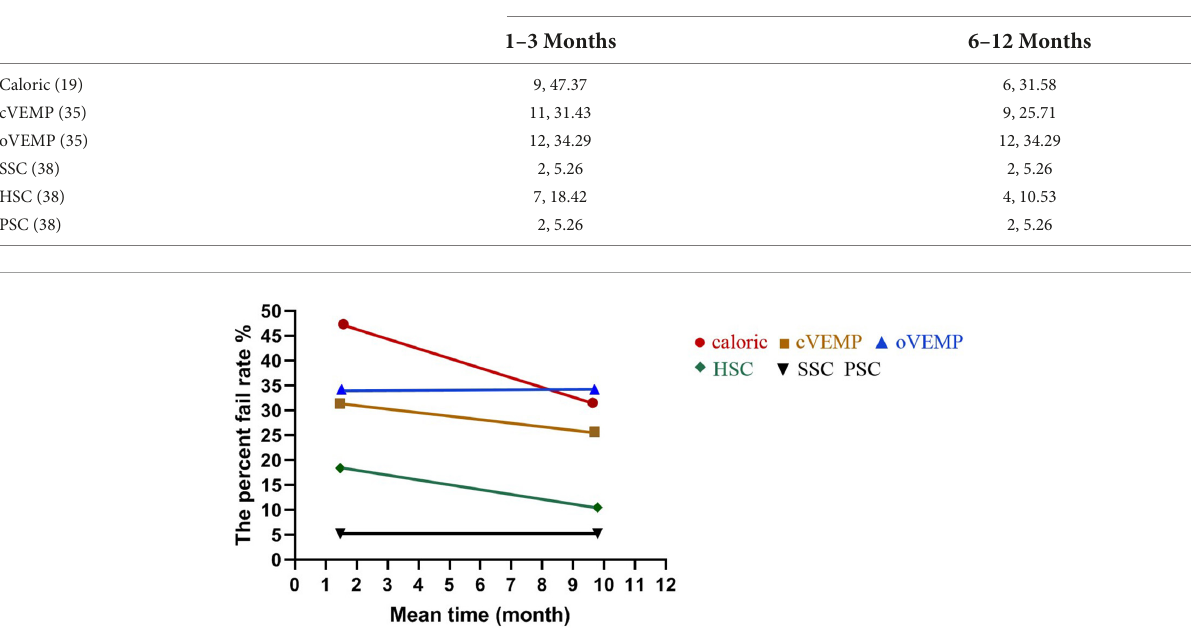
TABLE 4 The percent fail rate of each end-organ function on the implanted side at all five time points after surgery. Tests (total patient number)